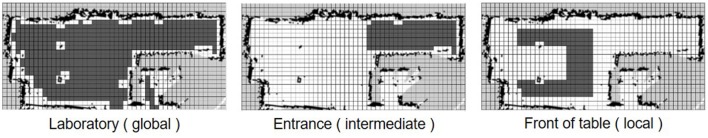
Examples of ground truth for regions where the location names are at the global, intermediate, and local levels. The area is mapped by a grid of 50 columns and 25 rows. The region of ground truth is represented by the gray grids.